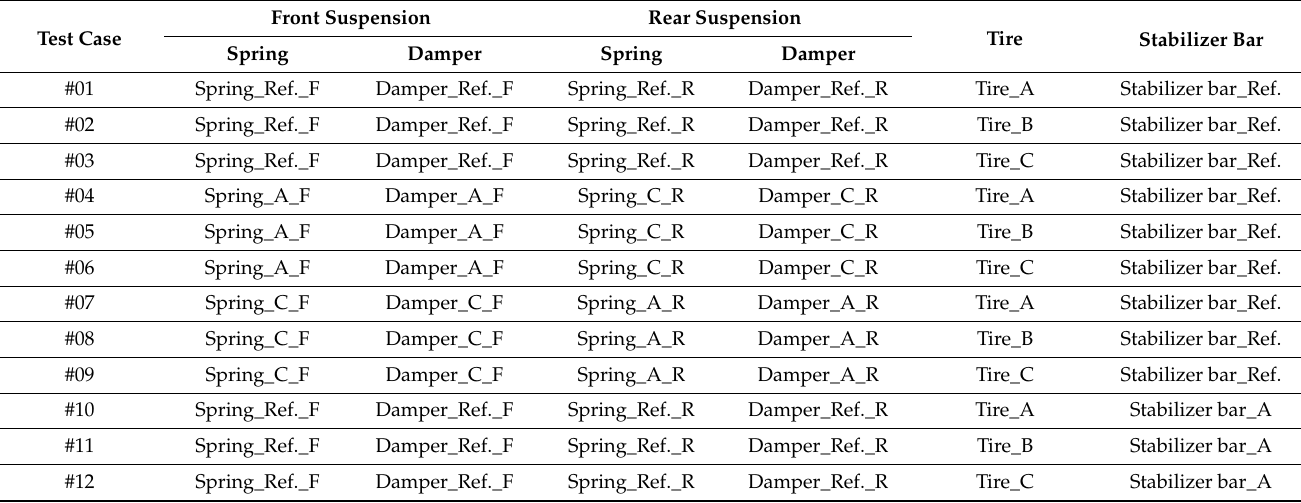
Table 6. Suspension, tire, and stabilizer bar parts from cornering test